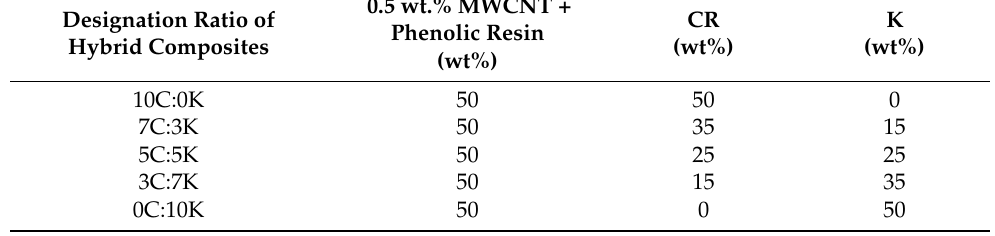
Table 2. Formulation of hybrid composites.